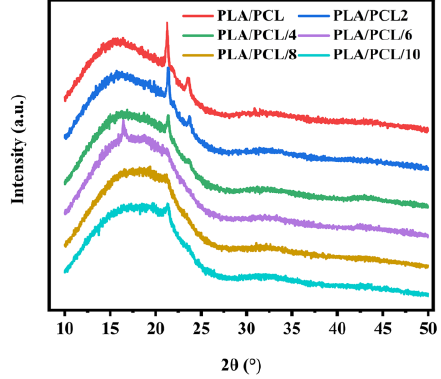
/ PCL with di ff erent additions of Figure 7. XRD patterns of PLA/PCL with different additions of EMA-GMA Figure 7. XRD patterns of PLA Figure 7. XRD patterns of PLA/PCL with different additions of EMA-GMA